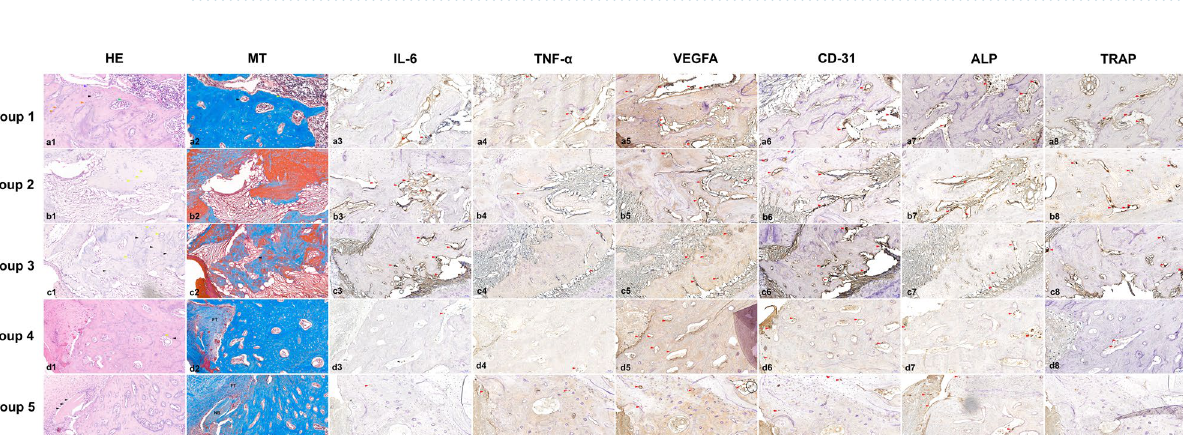
Table 6. Comparison of BMD and bone morphometry parameters between IP BRONJ model groups I and II based on time post-extraction. The statistical analysis was performed using student t testing. The data are depicted as the mean ± standard deviation. BMD bone mineral density, BV/TV bone volume/total volume (bone volume fraction), BS/BV bone surface/segmented bone volume (specific bone surface), BS/TV bone surface/total volume (bone surface density), Tb.Th. trabecular thickness, Tb.N. trabecular number, Tb.Sp. trabecular separation. *Group I was significantly higher than group II in BMD, BV/TV, and Tb.Th. ( p < 0.05). **Group II was significantly higher than group I in BS/BV, BS/TV, Tb.N., and Tb.Sp. ( p < 0.05).